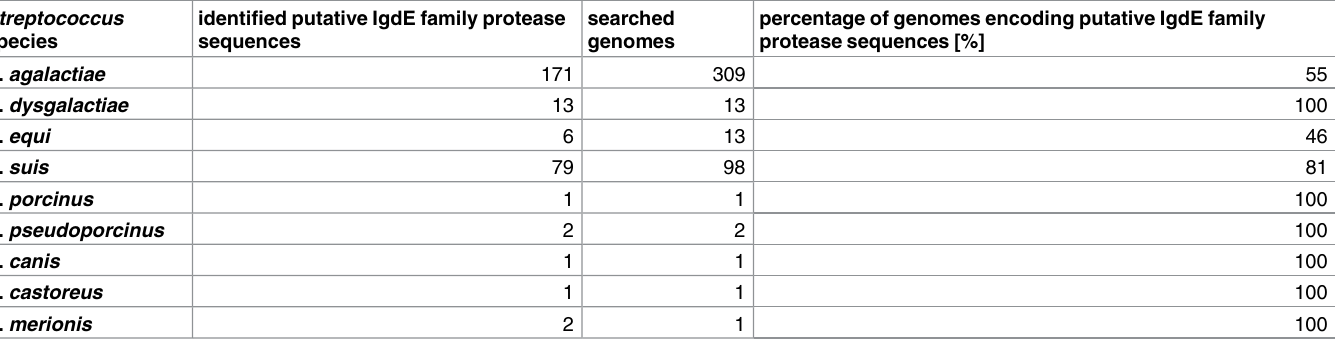
Table 3. Number of identified putative IgdE family protease sequences and searched genomes. Streptococcus identified putative IgdE family protease species sequences